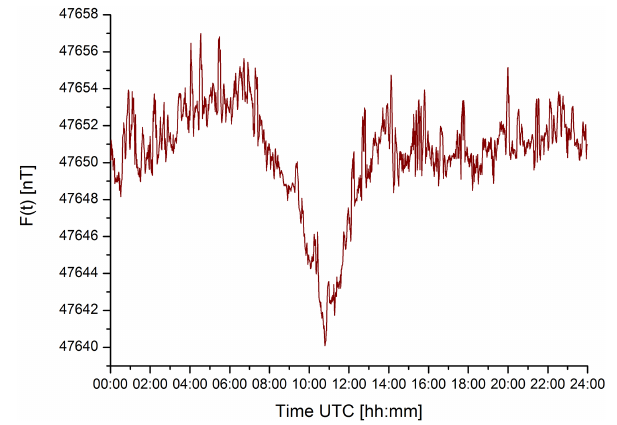
Figure 5. Daily variation of the geomagnetic field F(t) at Sinji Vrh during the geomagnetic calm day on 5 January 2013.